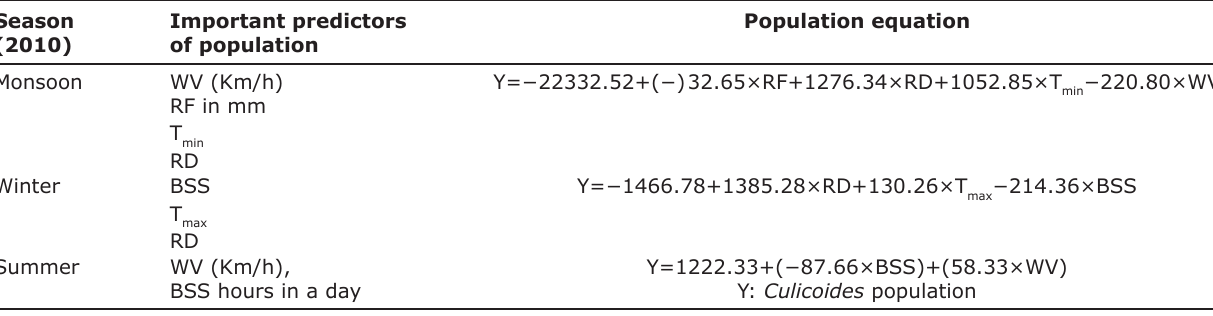
Table-4: Multiple regression analysis of weather parameters and Culicoides population for the year 2010. Season